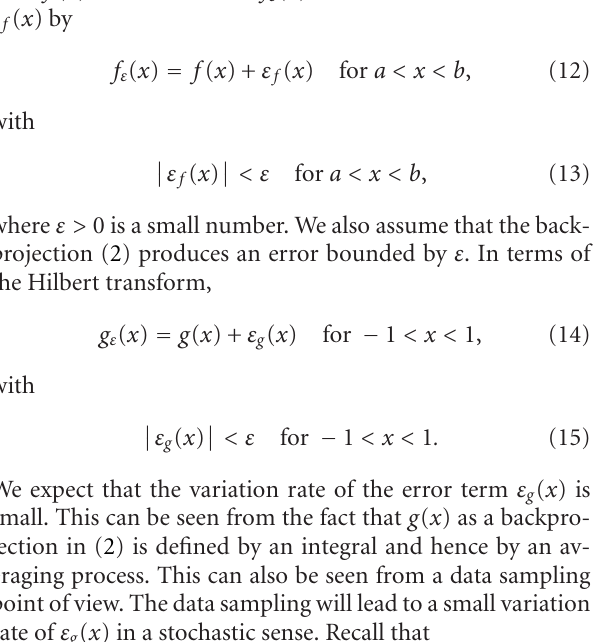
Figure 1: Setting for Theorem 1, where f ( x ) is supported on [ − 1,1] and known on ( a , b ), while its Hilbert transform known on ( a , c